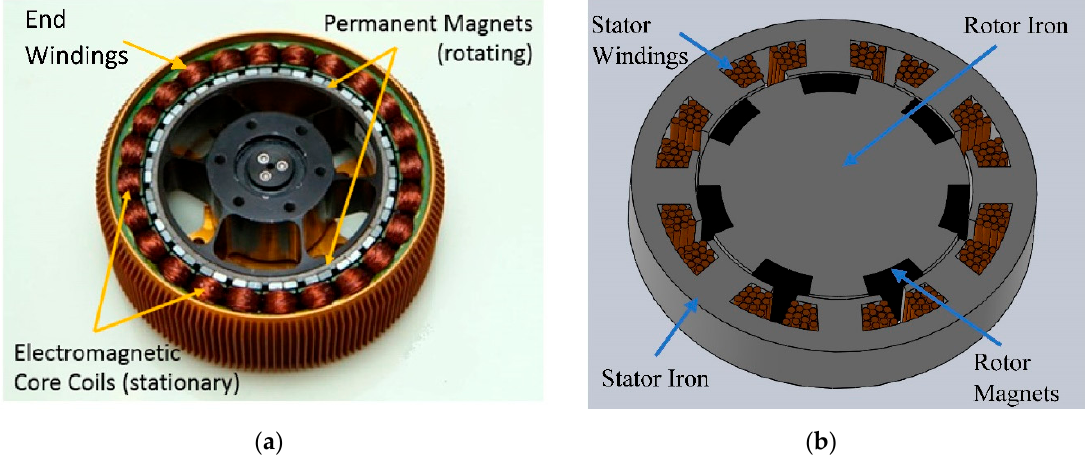
Figure 2. Radial flux permanent magnet electric motors: ( a ) digital image, and ( b ) computer aided design section view [9].